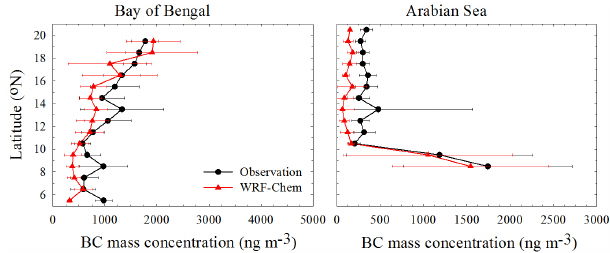
Figure 4. WRF-Chem predicted and observed latitudinal gradients in BC mass concentrations along the ICARB ship track in the Bay of Bengal and Arabian Sea regions. Horizontal bars represent 1 σ (standard deviation) variation in BC mass concentration averaged over a 1 ◦ latitude